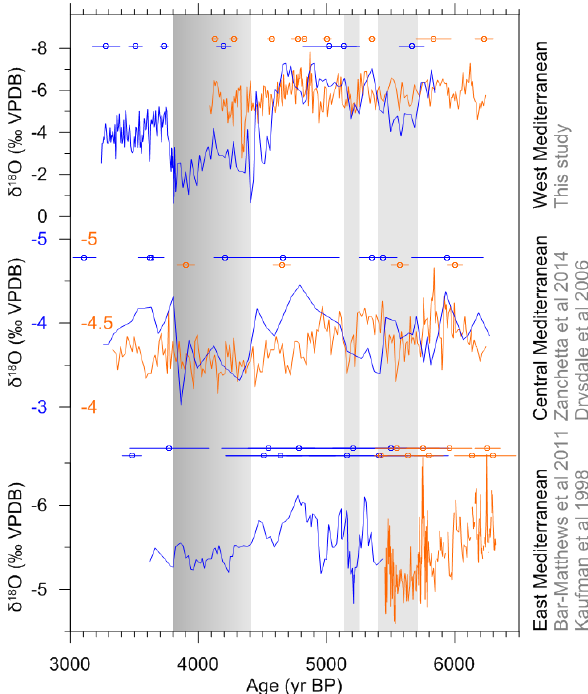
Figure 5. Comparison of high-resolution Mid-Holocene stalagmite δ 18 O records across the Mediterranean basin. From the top to bot- tom are stalagmite records from the Gueldaman GLD1 Cave in Northern Algeria of the Western-Mediterranean basin (this study), the Corchia Cave (Zanchetta et al., 2014) and the Renella Cave (Drysdale et al., 2006) in Central Italy of the Central Mediterranean basin, and the Soreq Cave (Bar-Matthews and Ayalon, 2011; Kauf- man et al., 1998) in Israel of Eastern-Mediterranean basin. Different stalagmites from each area are represented in distinct colors. U/Th dates with 2 σ errors are shown at the top of each curve. Ages are reported in years before